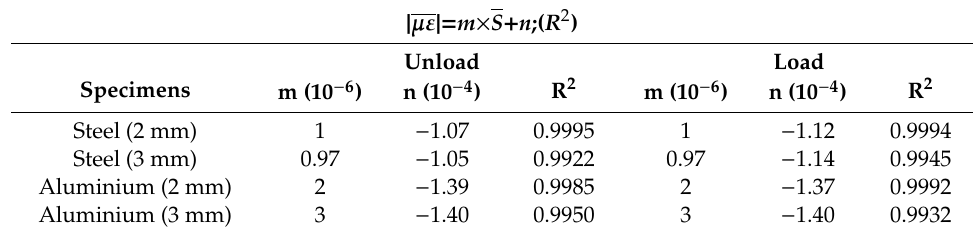
Table 1. Linear calibration for the data in Figure 9. The load and the unload results were fitted separately. |(cid:2246)(cid:2239)(cid:3364)(cid:3364)(cid:3364)(cid:3364)| = (cid:2195) × (cid:2175)(cid:3365) + (cid:2196); (cid:3435)(cid:2174) (cid:2779) (cid:3439)